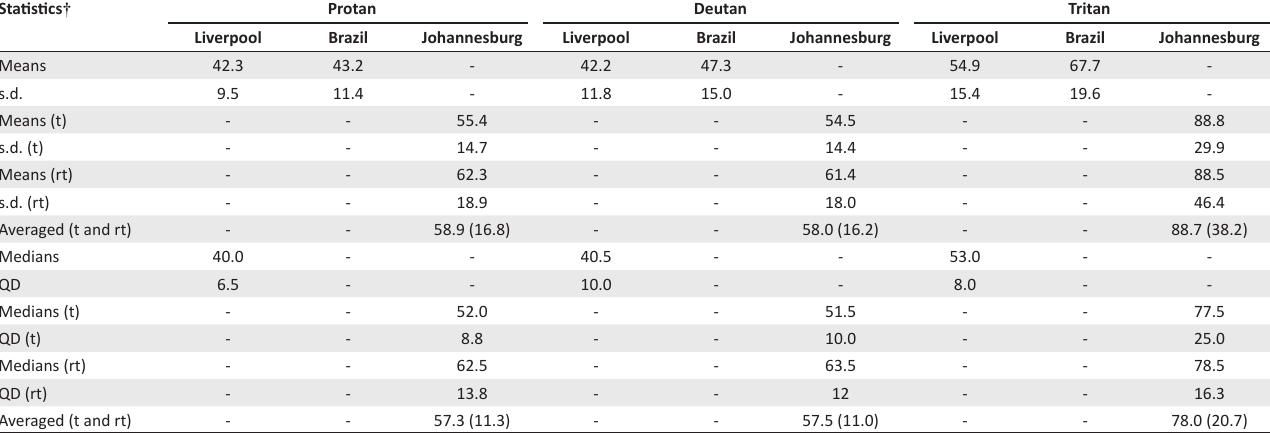
TABLE 6: Comparisons of means and standard deviations for the Cambridge Colour Test Trivector test between studies (Brazil 16 and Liverpool 15 ) and this study 20 ; medians and quartile deviation are included for Johannesburg 20 and Liverpool 14 . Statistics † Protan